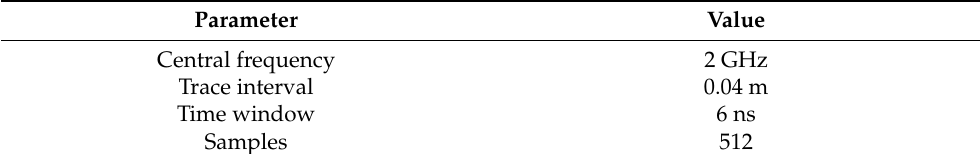
Figure 3. ( a ) The system used for GPR images acquisition and ( b ) GPR images of the field data collection [17].